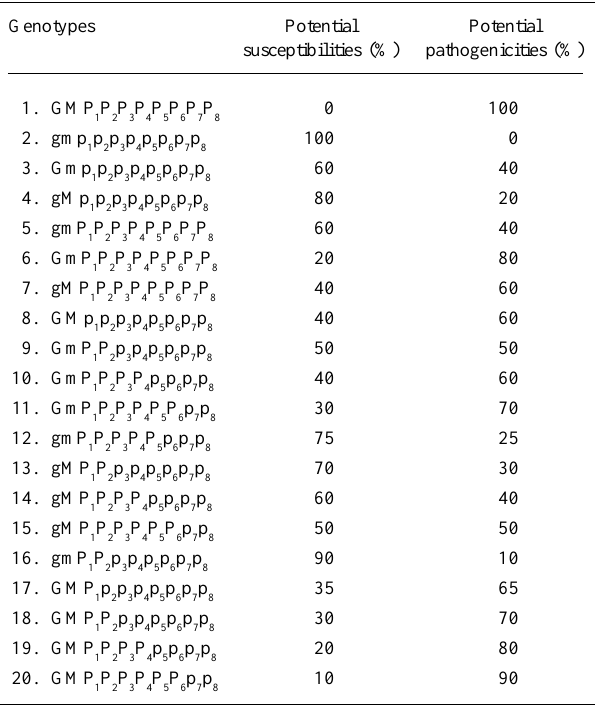
G and g = Gene of strong effect; M and m = gene of medium effect; P and p = gene of little effect; G, M and P = favorable alleles; g, m, p = unfavor- able alleles; all genotypes are homozygous.